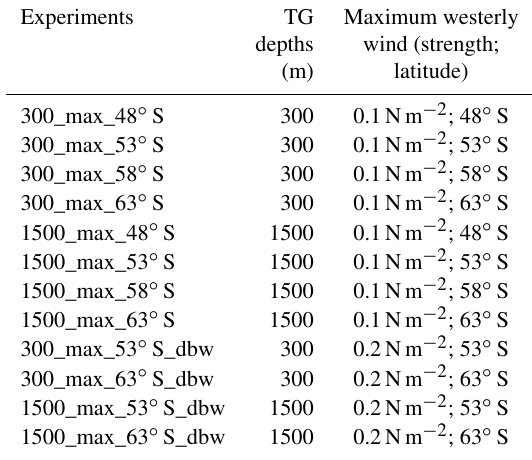
Table 1. Overview of sensitivity experiments. The “experiments” column gives names for each case, e.g. for the 300_max_53 ◦ S case, 300 represents 300m TG and max_53 ◦ S represents the maximum westerly wind of 53 ◦ S. The“maximum westerly wind” column pro- vides the strength and latitudinal position of maximum westerly wind for each